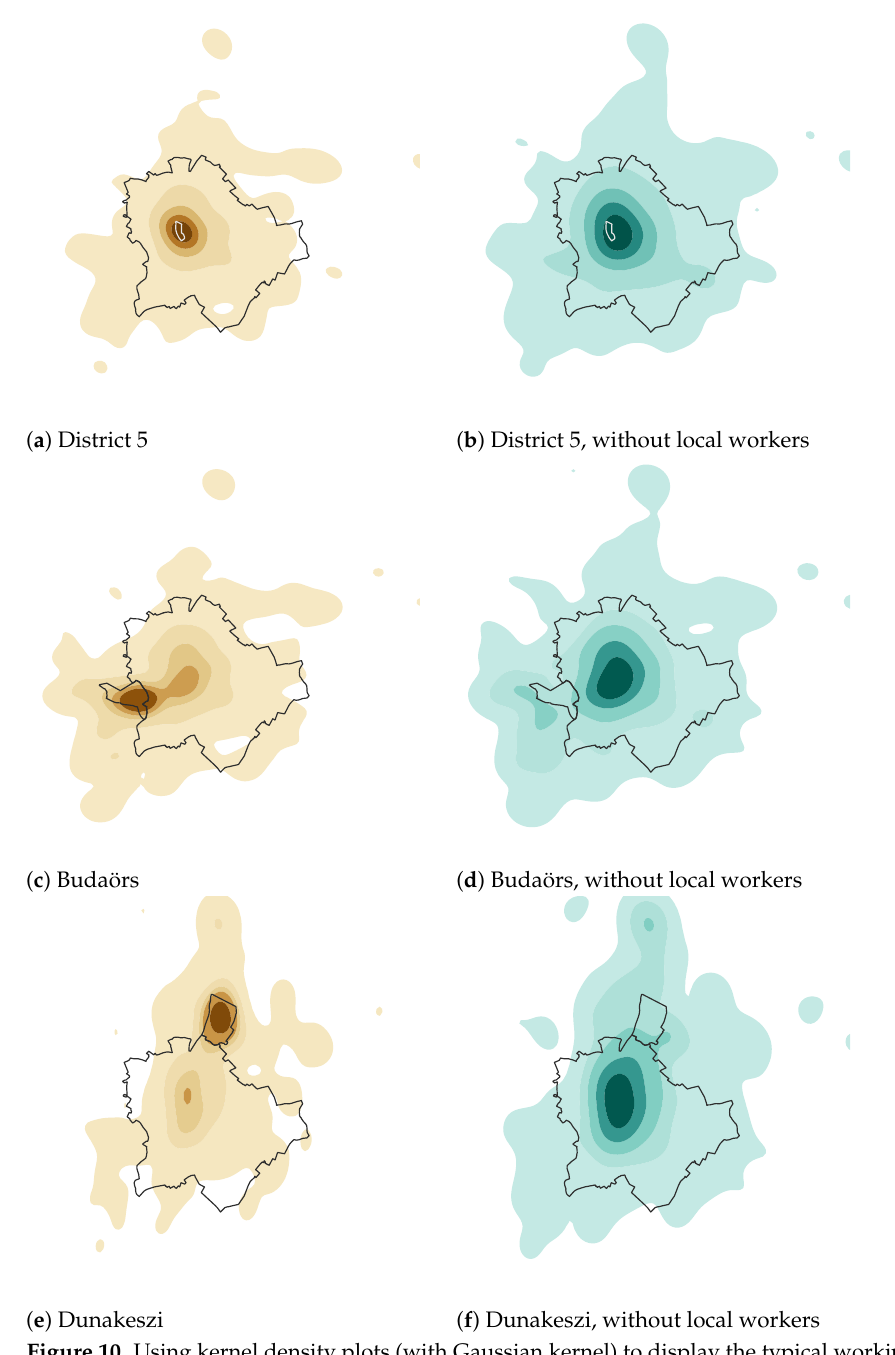
Figure 10. Using kernel density plots (with Gaussian kernel) to display the typical working locations for three selected settlements and a district of Budapest, with ( a , c , e ) and without ( b , d , f ) local workers. The administrative boundaries of Budapest and the selected settlements are also